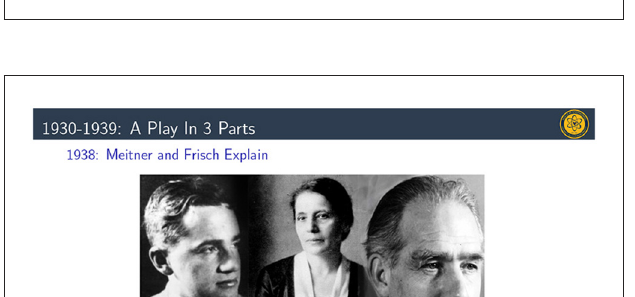
FIGURE5 Important female players in twentieth-century physics—Curie. Lecture W2L3.